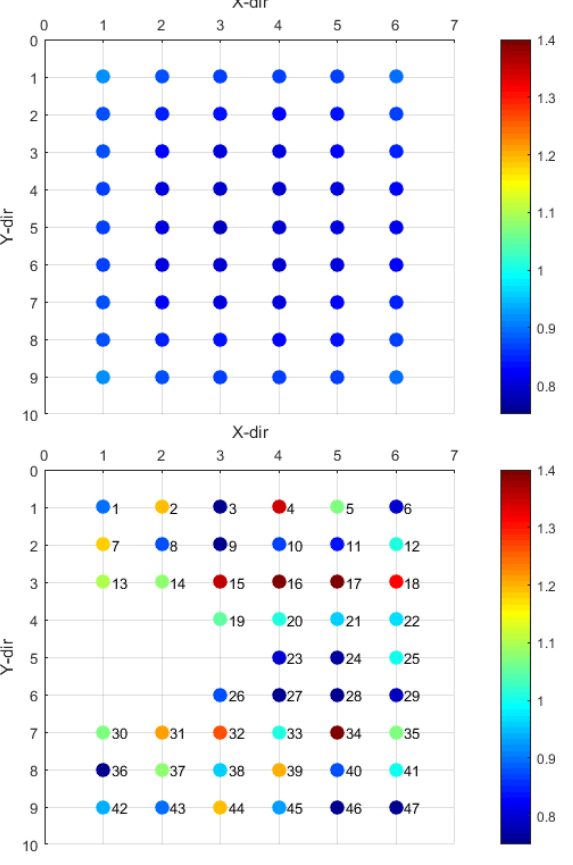
Figure 7. The accuracies of the practical results.